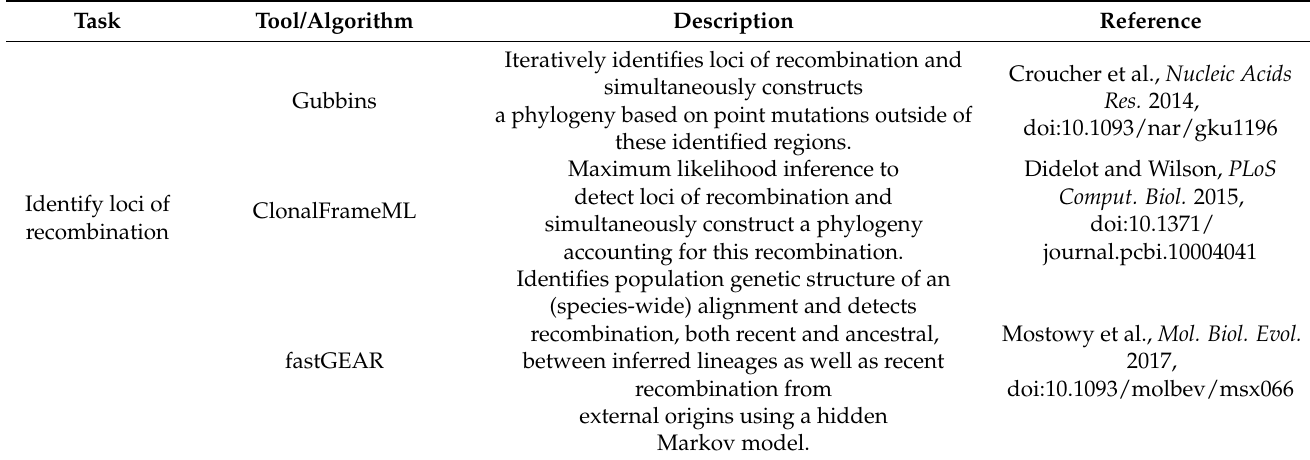
Table 1. Software tools available for dating phylogenies.